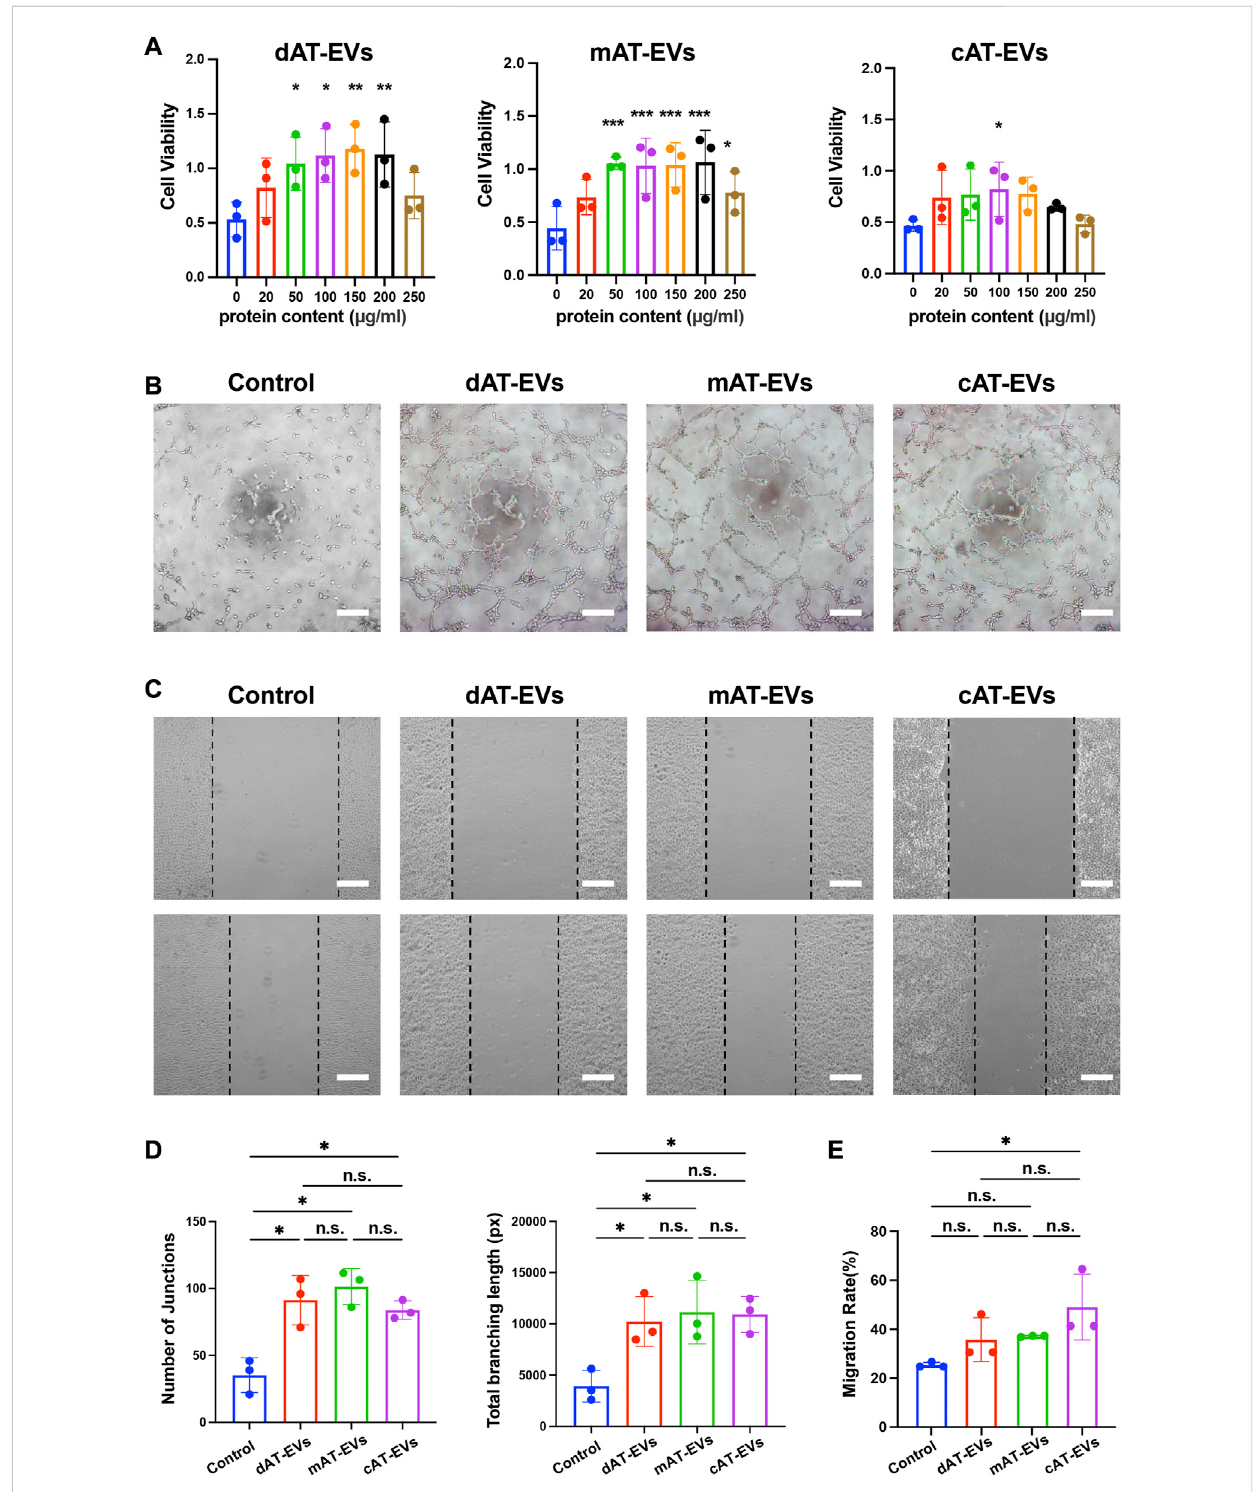
FIGURE 3 AT-EVs promoted theviability,tube formation, andmigrationofhuman umbilical veinendothelialcells(HUVECs) in vitro (A) Cell viability of HUVECs incubated with different concentrations of AT-EVs for 72 h ( n = 3). (B) Tube formation of HUVECs, observed under alight microscope ( n = 3). Scale bar = 250 μ m. (C) Migration of HUVECs after 24 h incubation with 100 μ g/mL AT-EVs (n = 3). Scale bar = 250 μ m. (D) Statistical analysis of tube formation of HUVECs (total branching length and number of junctions) ( n = 3). (E) Statistical analysis of HUVEC migration ( n = 3). n. s. no signi fi cant difference observed between groups. * p < 0.05, ** p < 0.01, *** p <